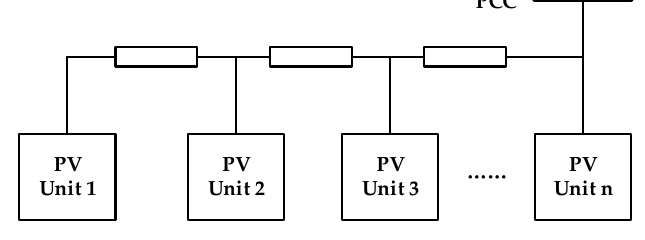
Figure 5. Trunk topology of a PV power plant.